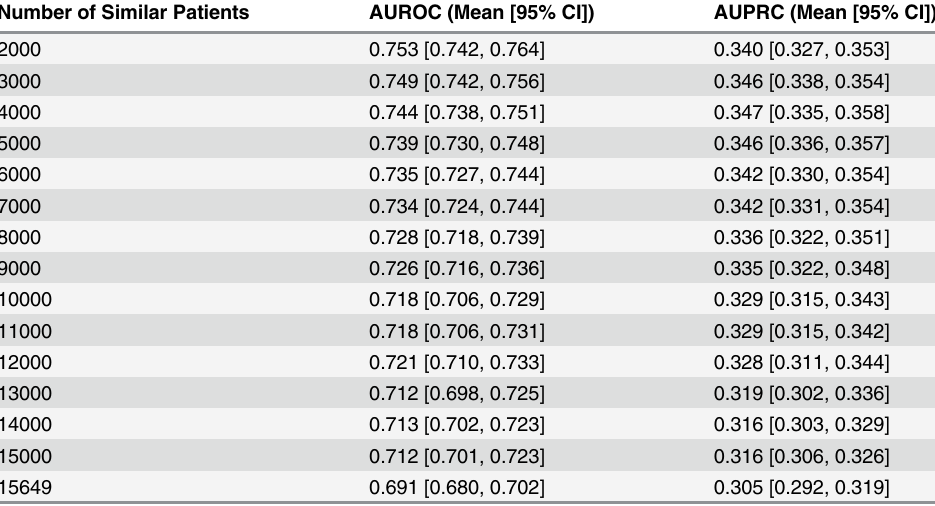
Table 4. Mortality prediction performance of decision trees as a function of the number of similar pa- tients used in